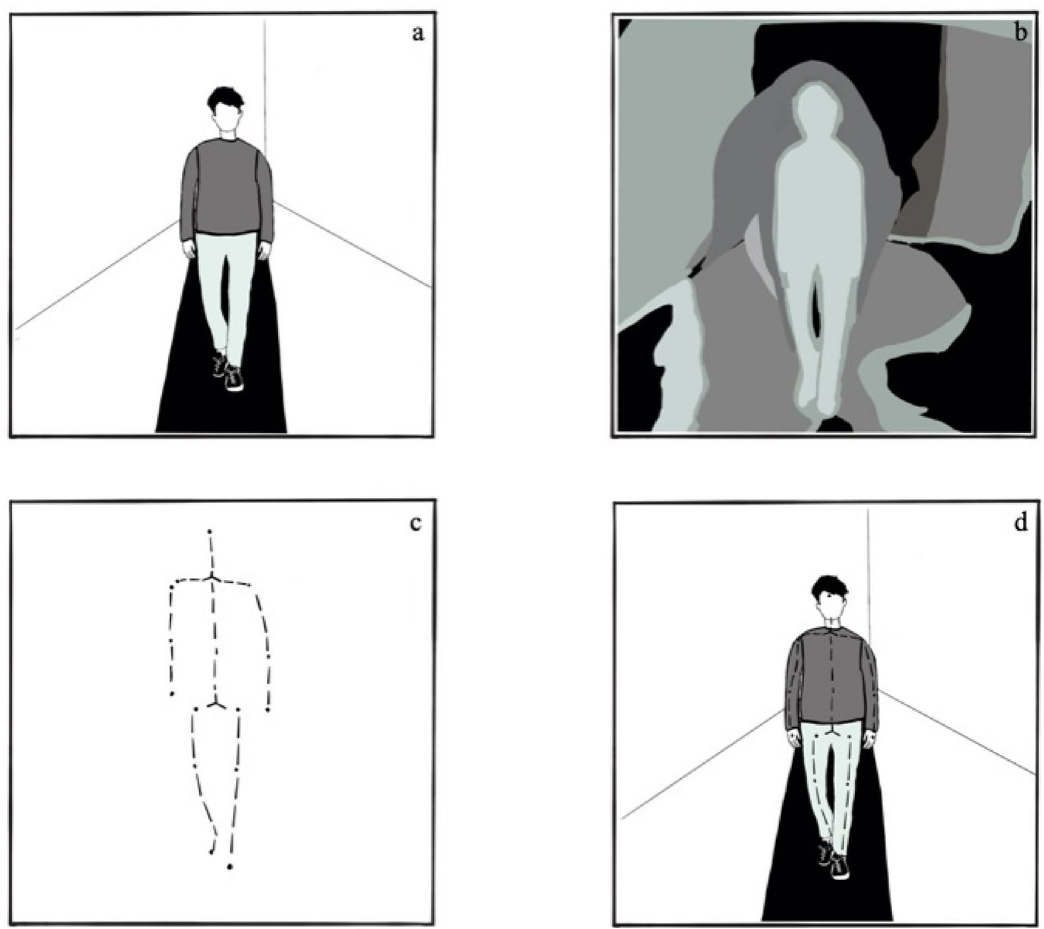
Figure 1. An illustration of the data captured by the Kinect motion sensor imaging technique. ( a ) RGB image (similar to regular video camera), ( b ) depth contour image, ( c ) estimated skeletal joints, ( d ) mapping of the estimated skeletal joints onto the RGB image. This study only used the output as shown in image ( c ). Illustration from Leonore Blume (https:// noblu.